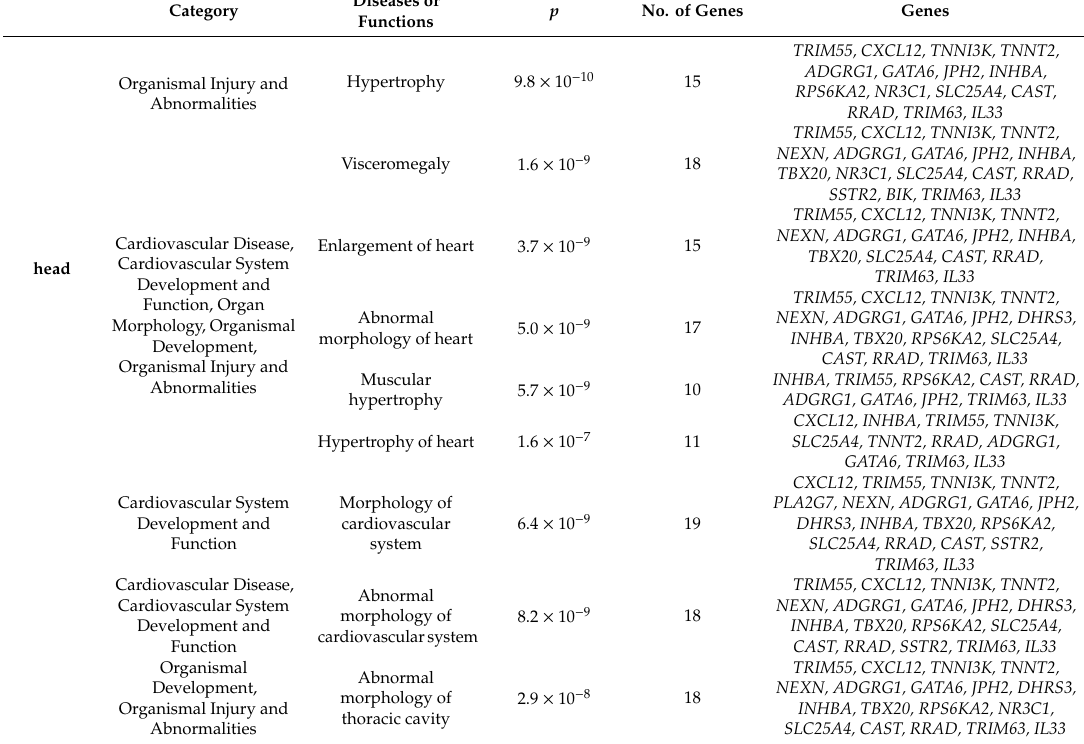
Table 1. Functional enrichment among genes di ff erentially expressed in embryonic tissues at d36 and d44 reflects organ-specific roles. Genes di ff erentially expressed in each of the five individual tissues sampled at embryonic d36 as compared d44 (FDR < 0.1) were analyzed for functional enrichment using